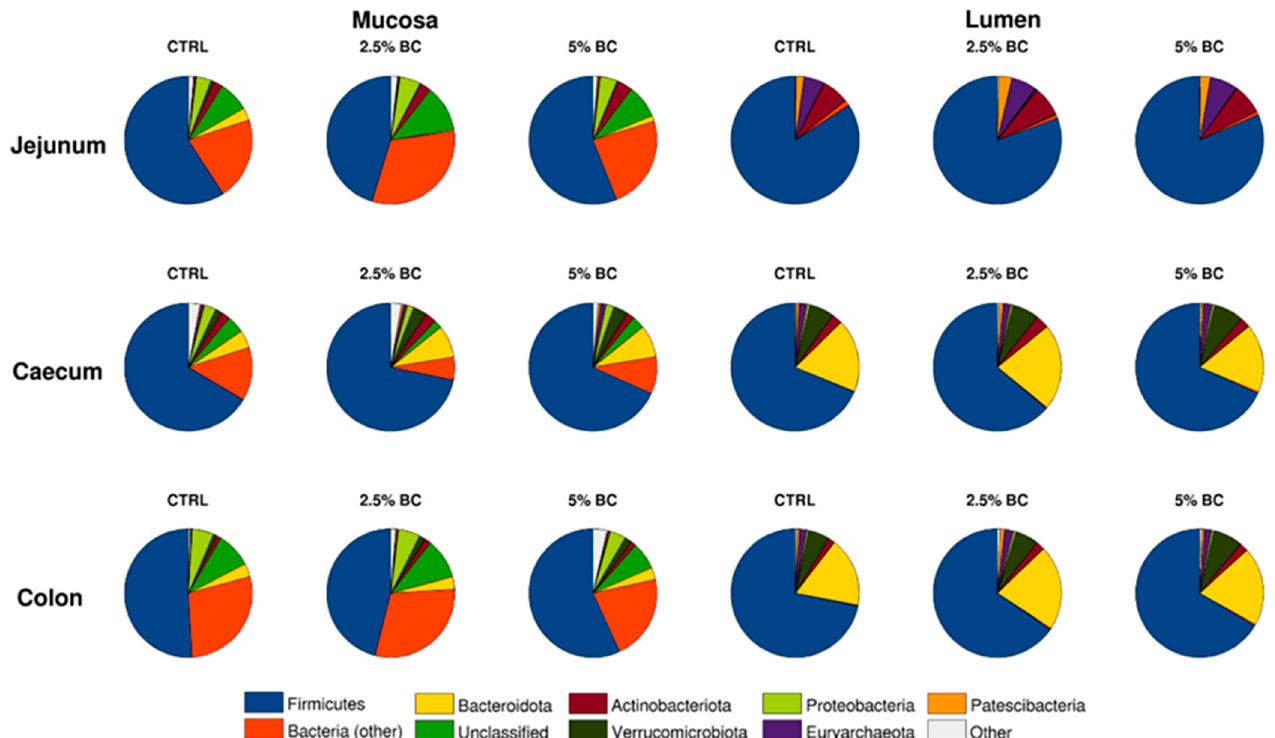
Figure 1. Pie charts representing the average composition of the microbiota for the samples divided by intestinal tract (jejunum, caecum, colon), sampling site (lumen, mucosa), and diet (CTRL, 2.5% BC, 5% BC) at the phylum level. Phyla with an average relative abundance <1% are reported in the “Other” category.